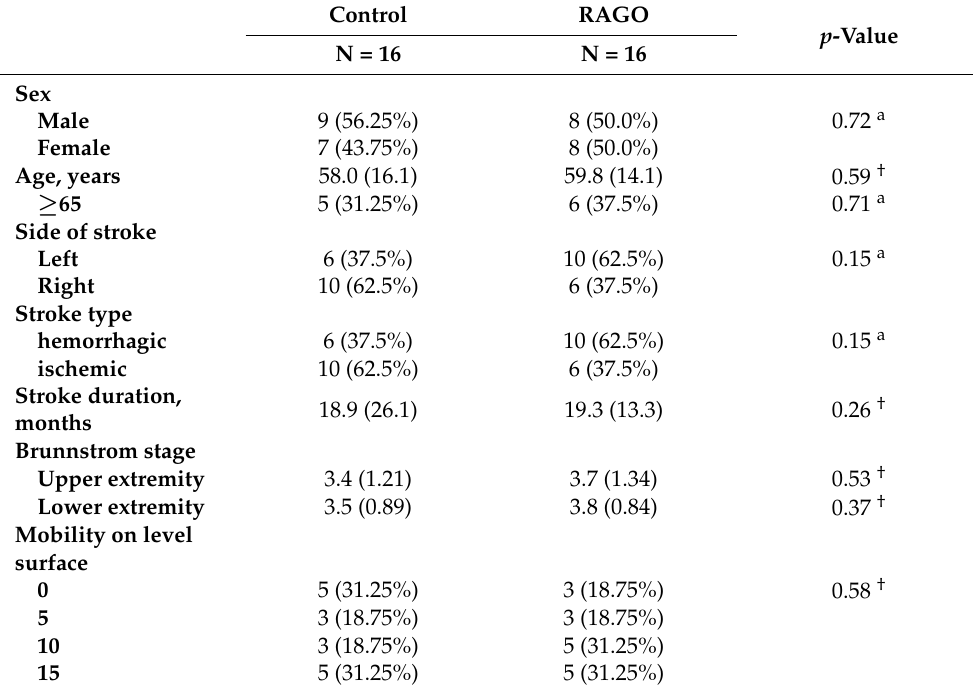
Table 1. Patient Baseline Characteristics.